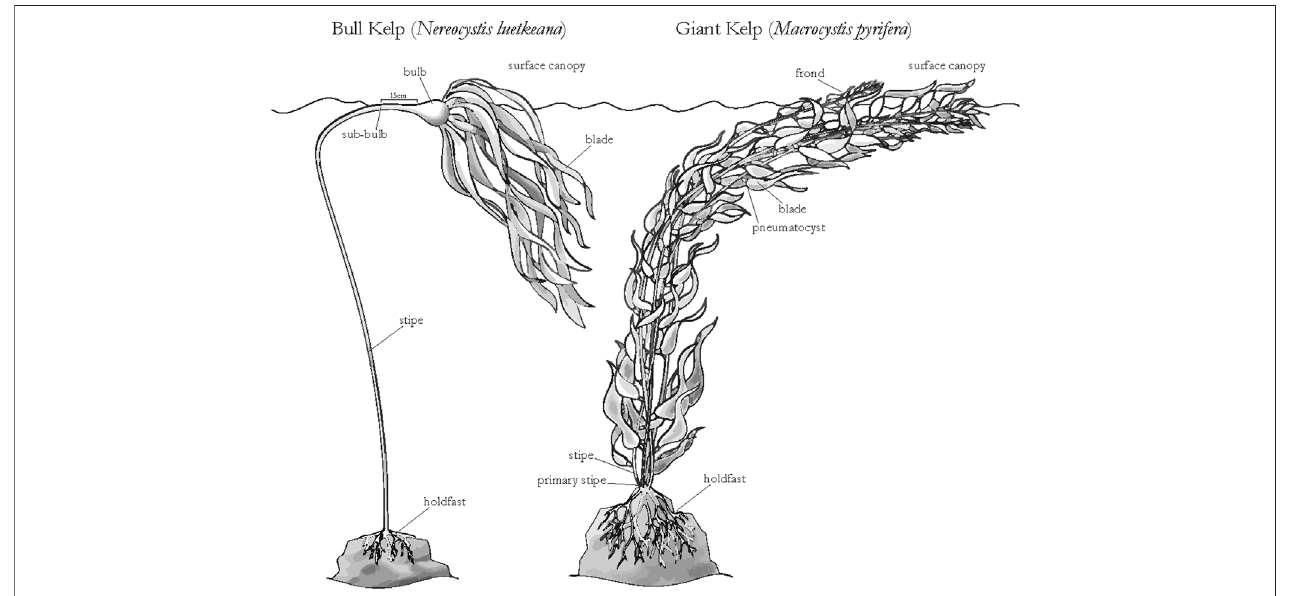
FIGURE 5 | Relevant morphometric characteristics of bull kelp (Nereocystis leutkeana) and giant kelp (Macrocystis pyrifera) adult sporophytes (image credit: Niky Taylor; UCSC).